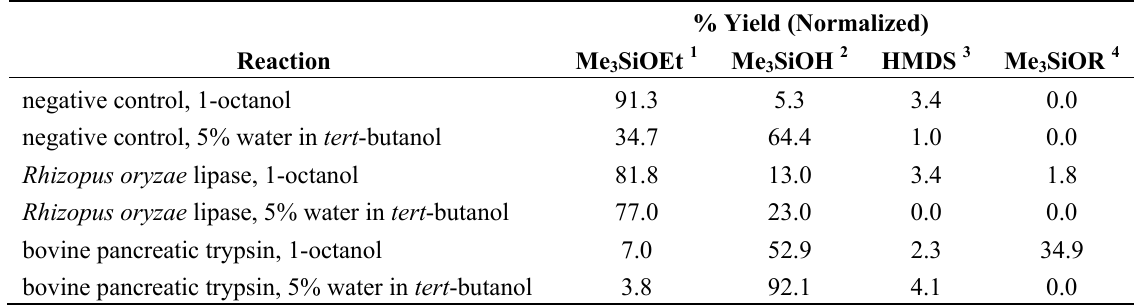
Table 1. Enzyme-catalyzed transetherification reactions between trimethylethoxysilane and 1-octanol or tert -butanol after 24 h at 25 °C.